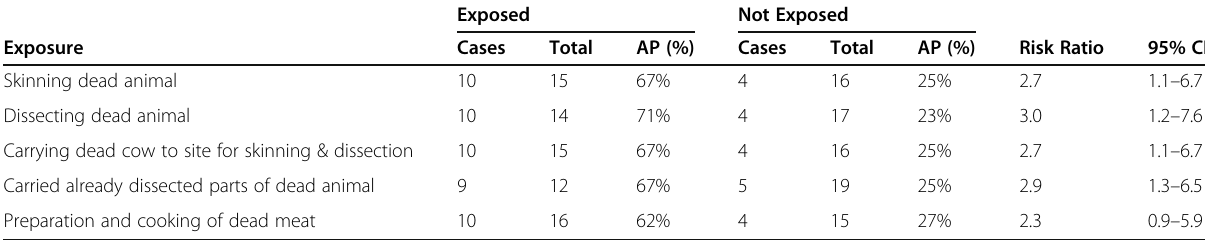
Table 2 Cases of cutaneous anthrax (suspected and confirmed) among household members exposed to carcasses of or products from animals suspected to have died of anthrax in Rhino-camp Sub-County, Arua District, January – May